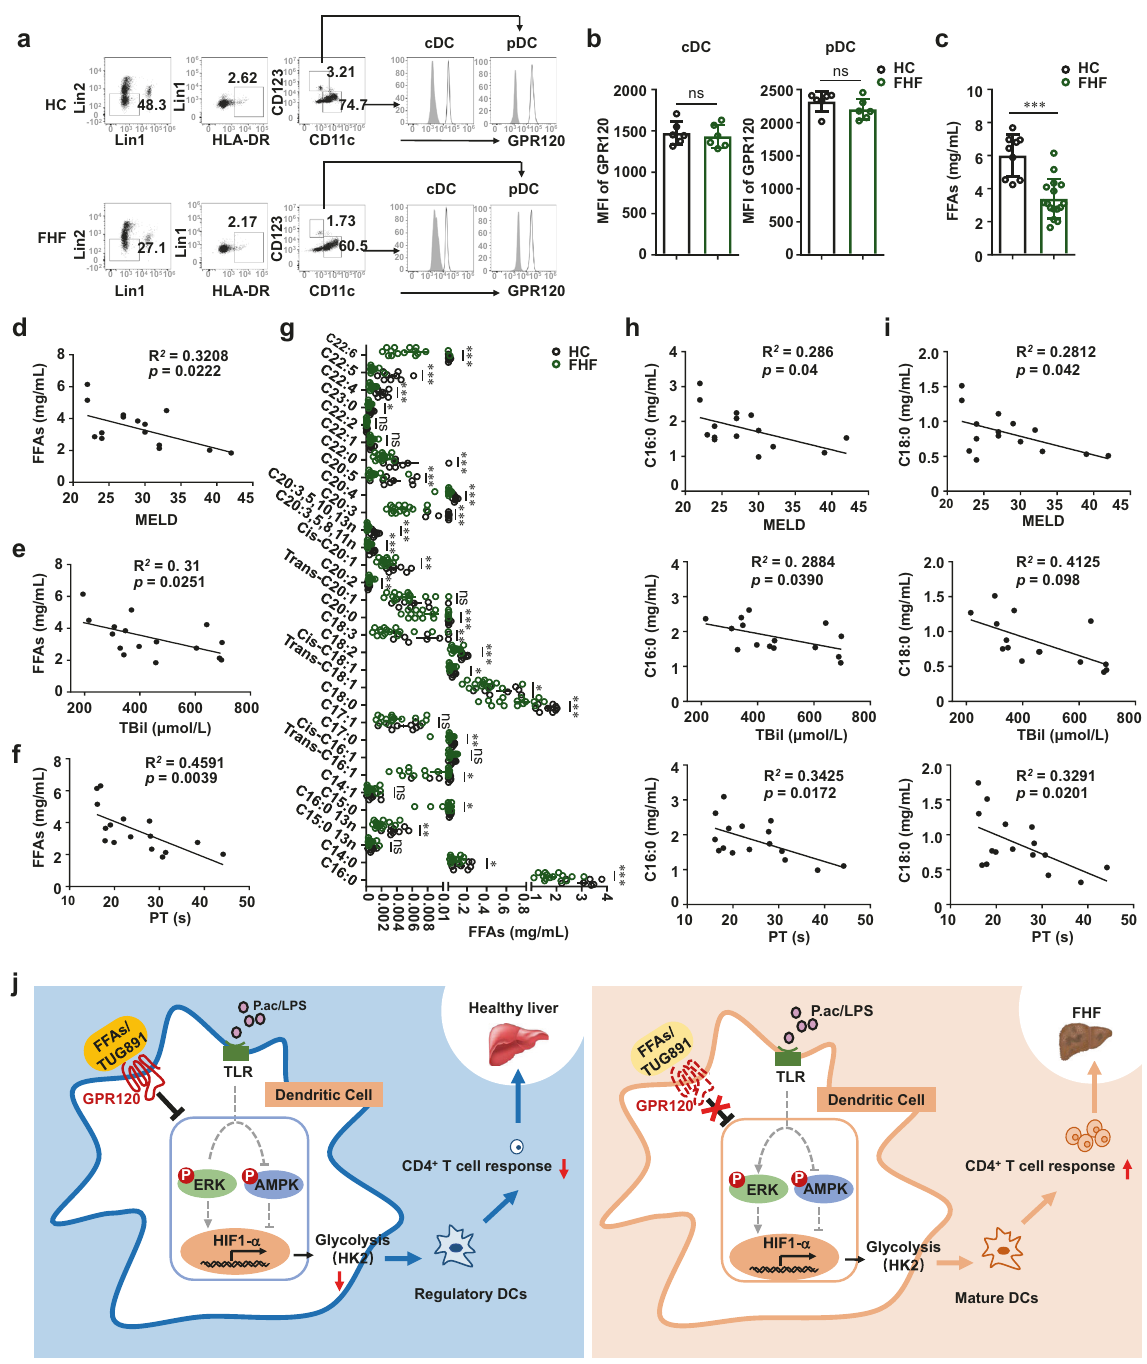
Fig. 8 Plasma FFA was negatively correlated with prognostic scores of patients with fulminant hepatitis. a Human peripheral blood (PB) cells were collected from healthy controls (HC) and FHF patients (HC: n = 9, FHF: n = 16). Cells were stained for surface markers, permeabilized with the intracellular fi xation and permeabilization buffer. Then cells were stained with anti-GPR120 antibody. Flow cytometry was used to measure GPR120 expression on conventional dendritic cells (cDCs) and plasmacytoid dendritic cells (pDCs) among the Lin1 − Lin2 − HLA-DR + cell population in PBMCs from HC and FHF patients. Representative images were shown. b Mean fl uorescence intensity (MFI) of GPR120 was shown (HC: n = 9, FHF: n = 16). c , g The levels of FFAs (C14 – C22) in the plasma of HC and FHF patients (HC: n = 9, FHF: n = 16) were measured by Gas